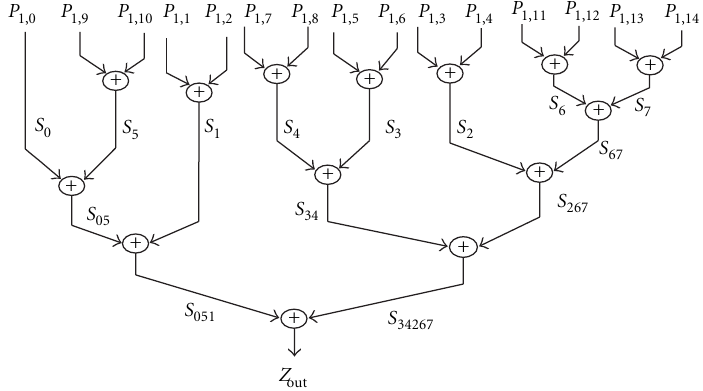
Figure 9: Flow digram of the additions required for a 256 × 256-bit